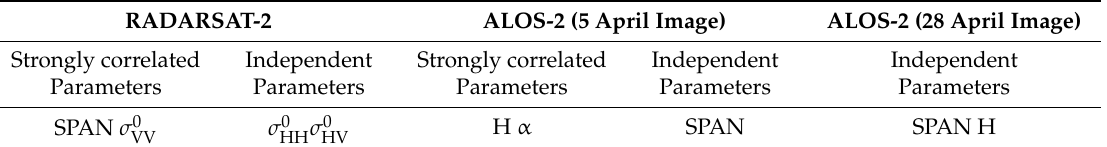
Table 4. Grouping of strongly correlated and independent polarimetric